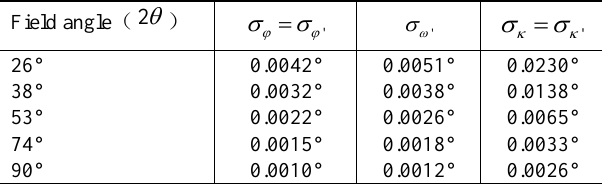
Table 2. Standard deviation of relative orientation elements with different field angles